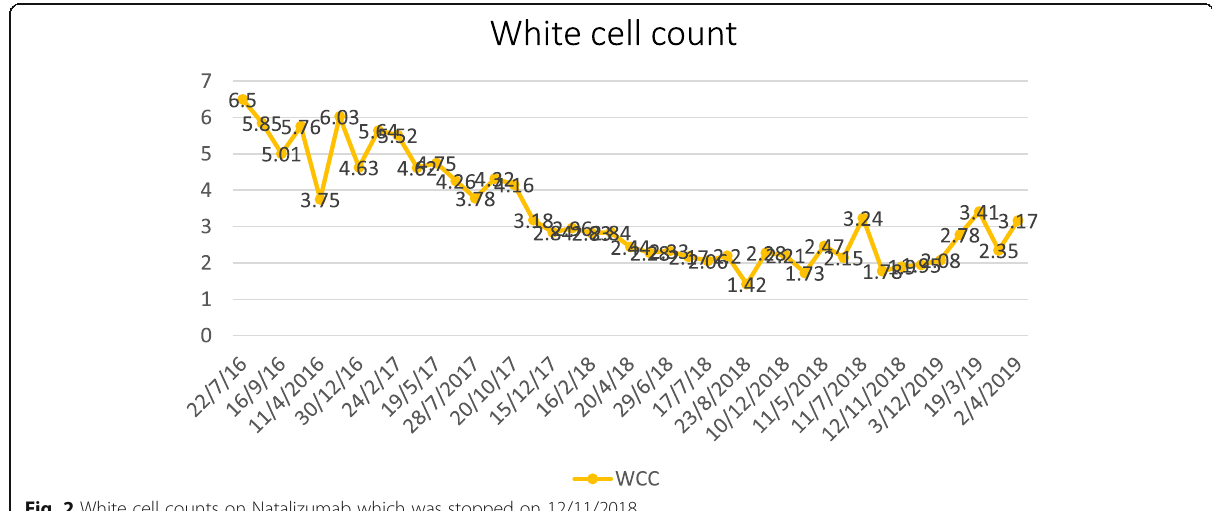
Fig. 2 White cell counts on Natalizumab which was stopped on 12/11/2018